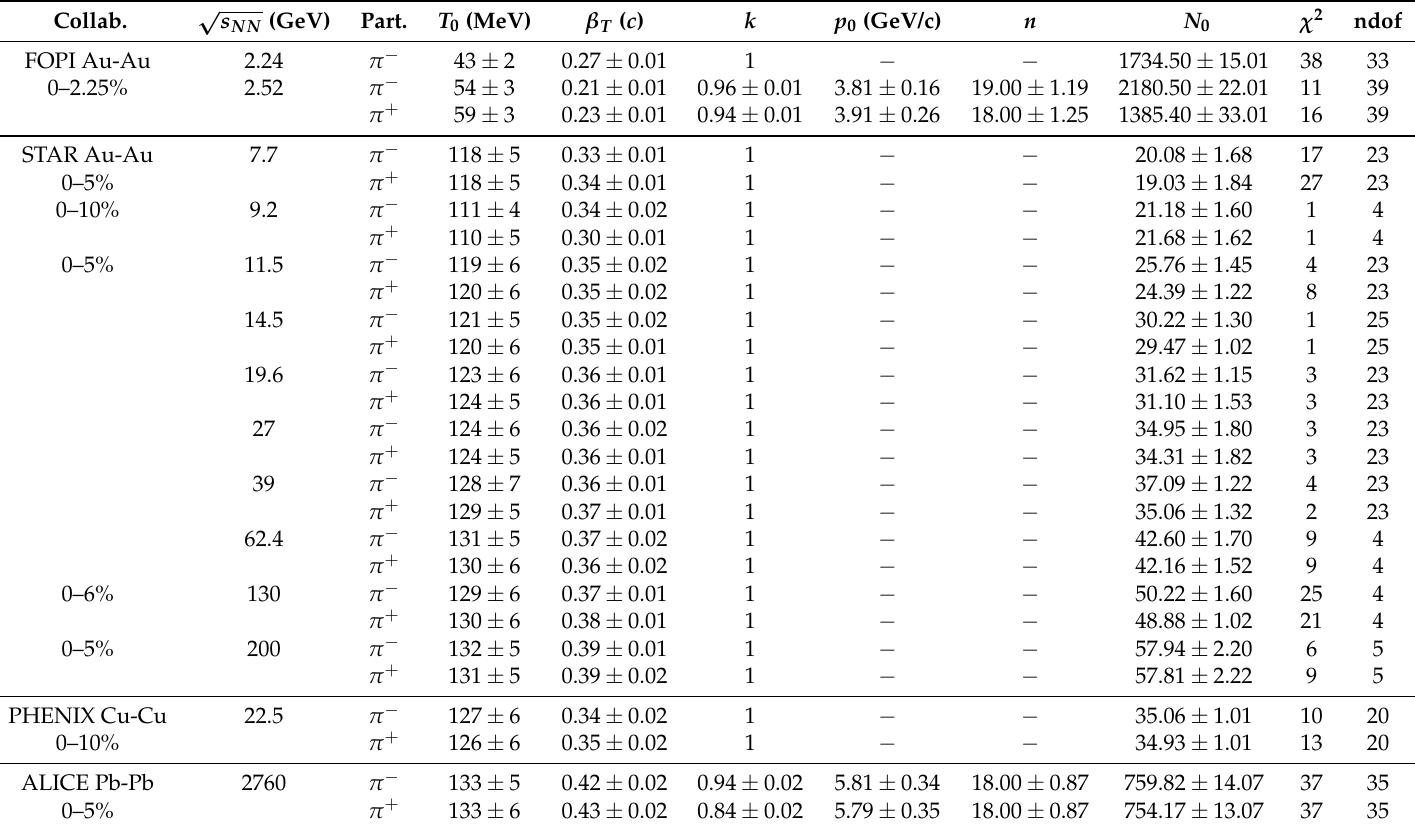
Table A3. Values of T 0 , β T , k , p 0 , n , N 0 , χ 2 , and ndof corresponding to the solid (dotted) curves for π − ( π + ) spectra in Figure